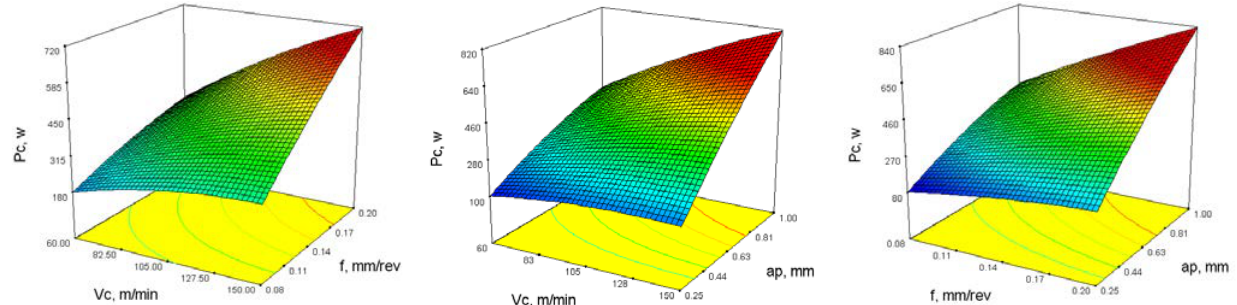
Fig. 14. Surface and contour plots for Kc